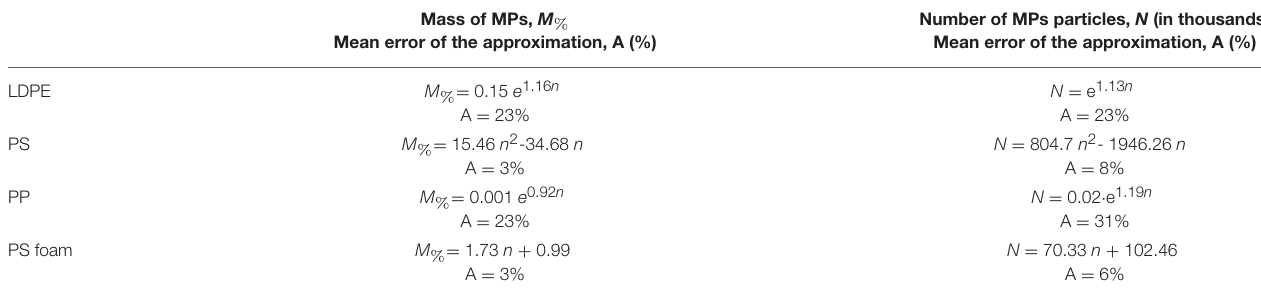
TABLE 5 | Summary of the best fit models for different plastics from Tables 3 , 4 . Mass of MPs, M % Mean error of the approximation, A (%)